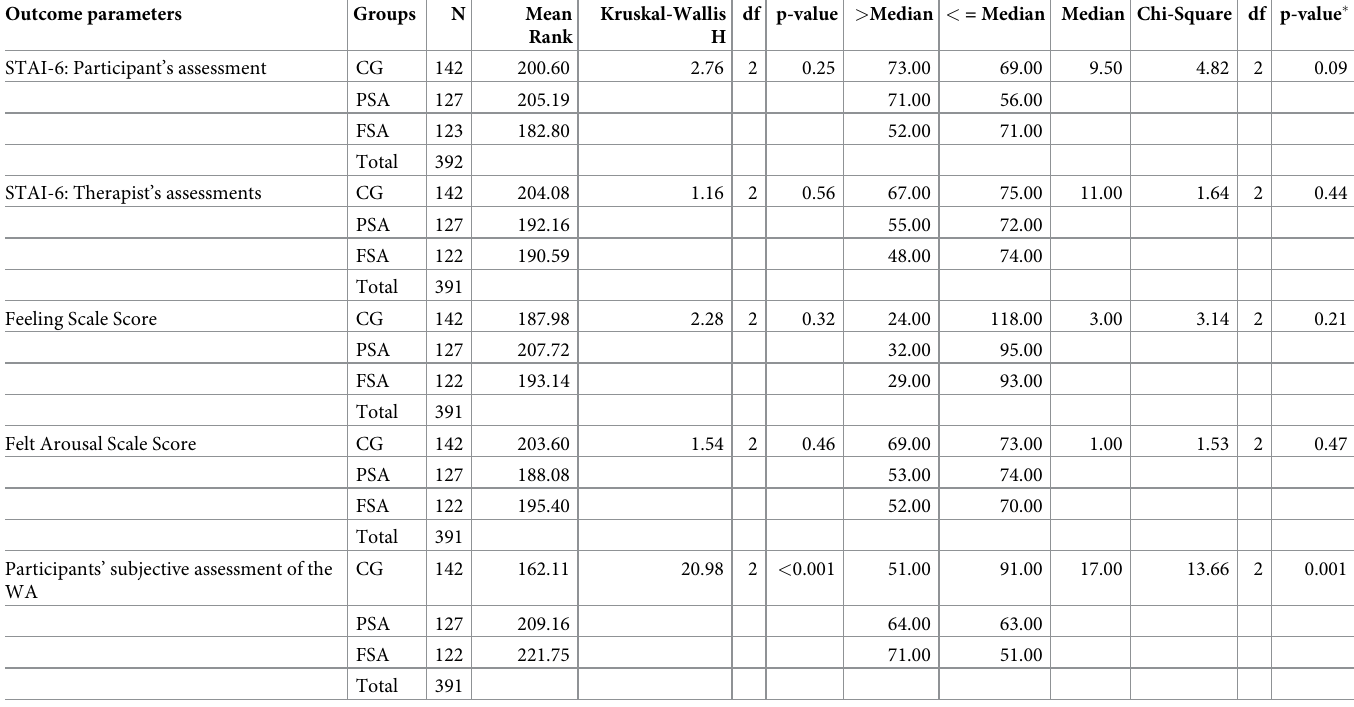
Table 7. Intergroup comparison of anxiety and mood of the participants in the different waiting area setups. Outcome parameters